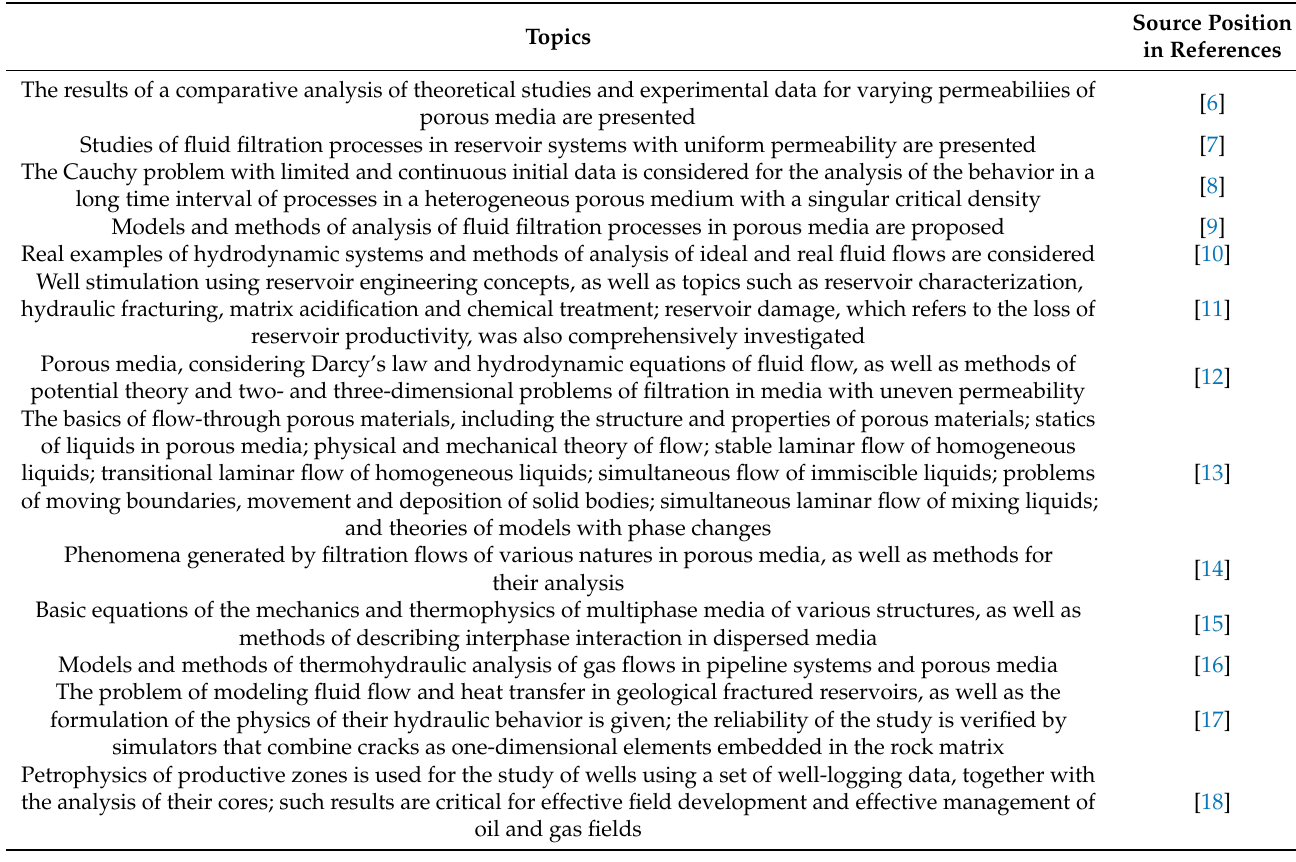
Table 1. Topics of reviewed literature